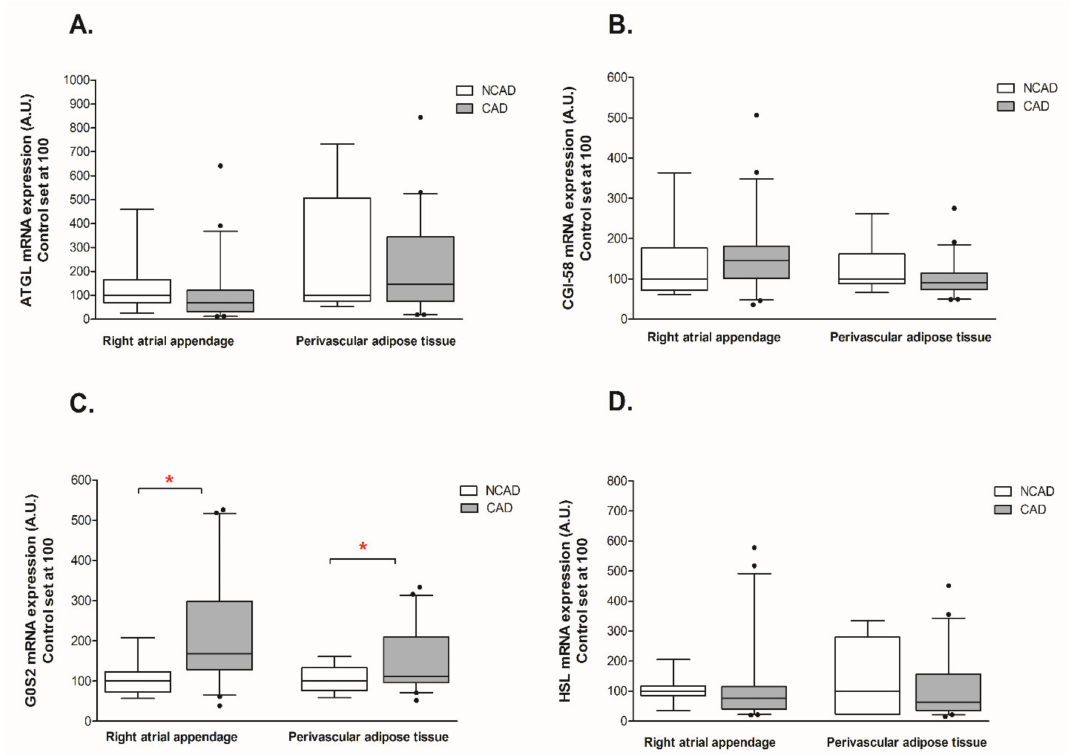
Figure 2. Myocardial and perivascular adipose tissue genes expression of ( A ) adipose triglyceride lipase (ATGL), ( B ) comparative gene identification 58 (CGI-58), ( C ) G0 / G1 switch gene 2 (G0S2), ( D ) hormone-sensitive lipase (HSL) in the coronary atherosclerosis (CAD, n = 42) and control (NCAD, n = 11) patients. The inner horizontal line of a box represents the median. Box boundaries: 25–75 percentile; whiskers 5–95 percentile. Data are expressed as median ± SEM. For the sake of clarity, the control group median was set at 100, and the CAD group was scaled with respect to NCAD. * p < 0.05 vs. control